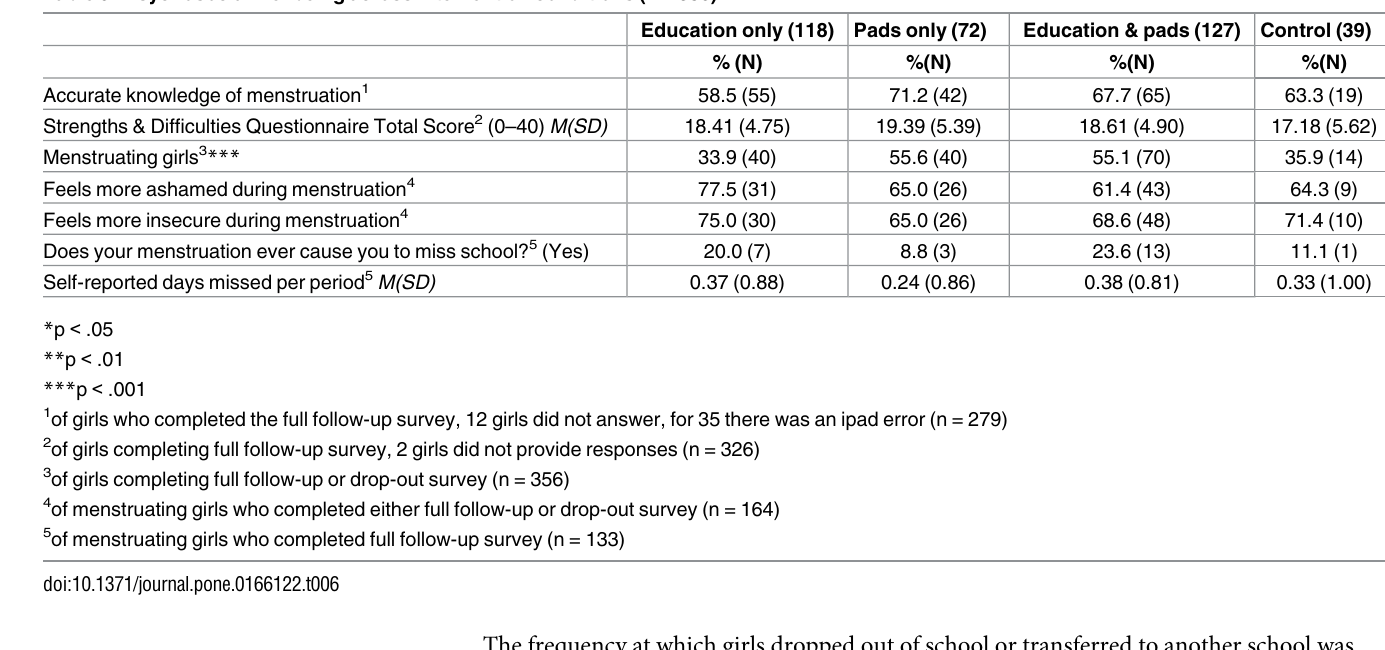
Table 6. Psychosocial wellbeing across intervention conditions (n =